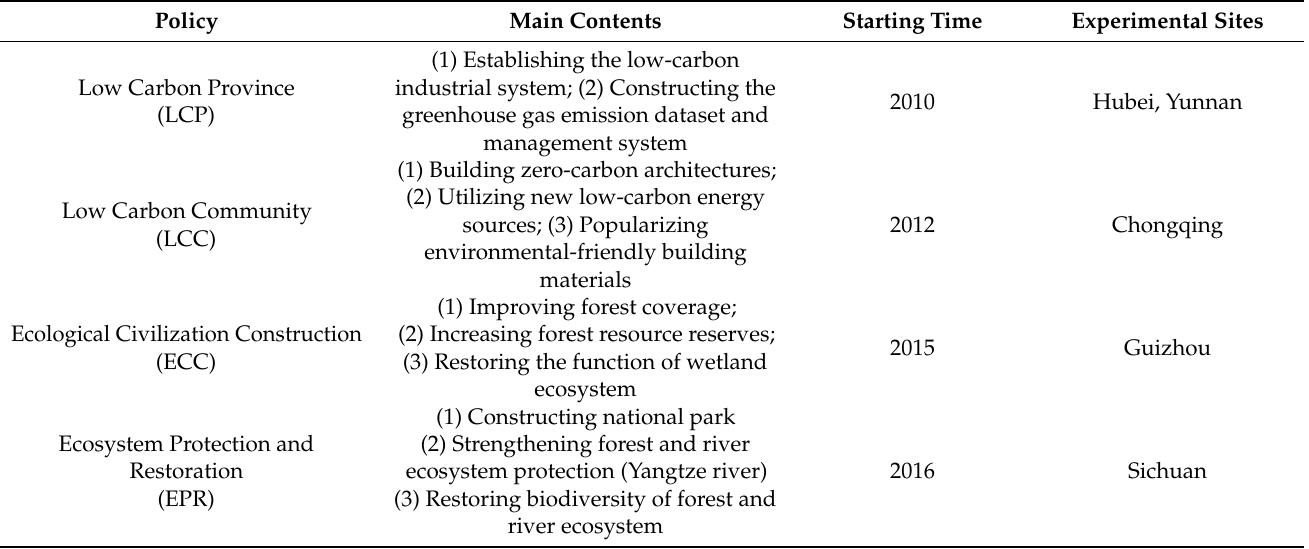
Table 3. Major environmental policies and regarding experimental